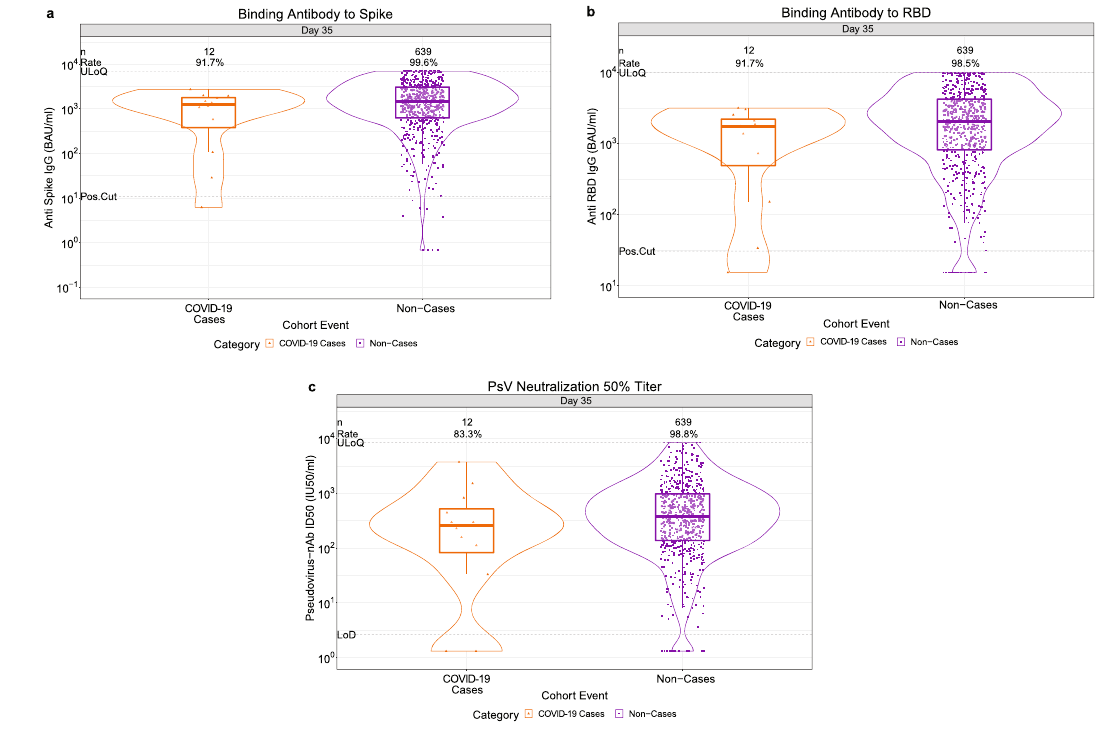
Fig. 1 | D35 antibody marker level by COVID-19 outcome status in baseline SARS-CoV-2 negative per-protocol vaccine recipients (U.S. study sites). a Anti- spike IgG concentration, b anti-RBD IgG concentration, and c pseudovirus (PsV) neutralization nAb-ID50 titer ( n =12 cases, n =639 non-cases for each a – c ). The violin plots contain interior box plots with upper and lower horizontal edges the 25thand75thpercentilesofantibodylevelandmiddlelinethe50thpercentile,and vertical bars the distance from the 25th (or 75th) percentile of antibody level and the minimum (or maximum) antibody level within the 25th (or 75th) percentile of antibodylevelminus(orplus)1.5timestheinterquartilerange.Atbothsidesofthe box, a rotated probability density curve estimated by a kernel density estimator with a default Gaussian kernel is plotted. Frequencies of participants with positive spike IgG/detectable nAb ID50 responses were computed with inverse probability ofsamplingweighting(reportedatthetopoftheplotsas “ Rate ”